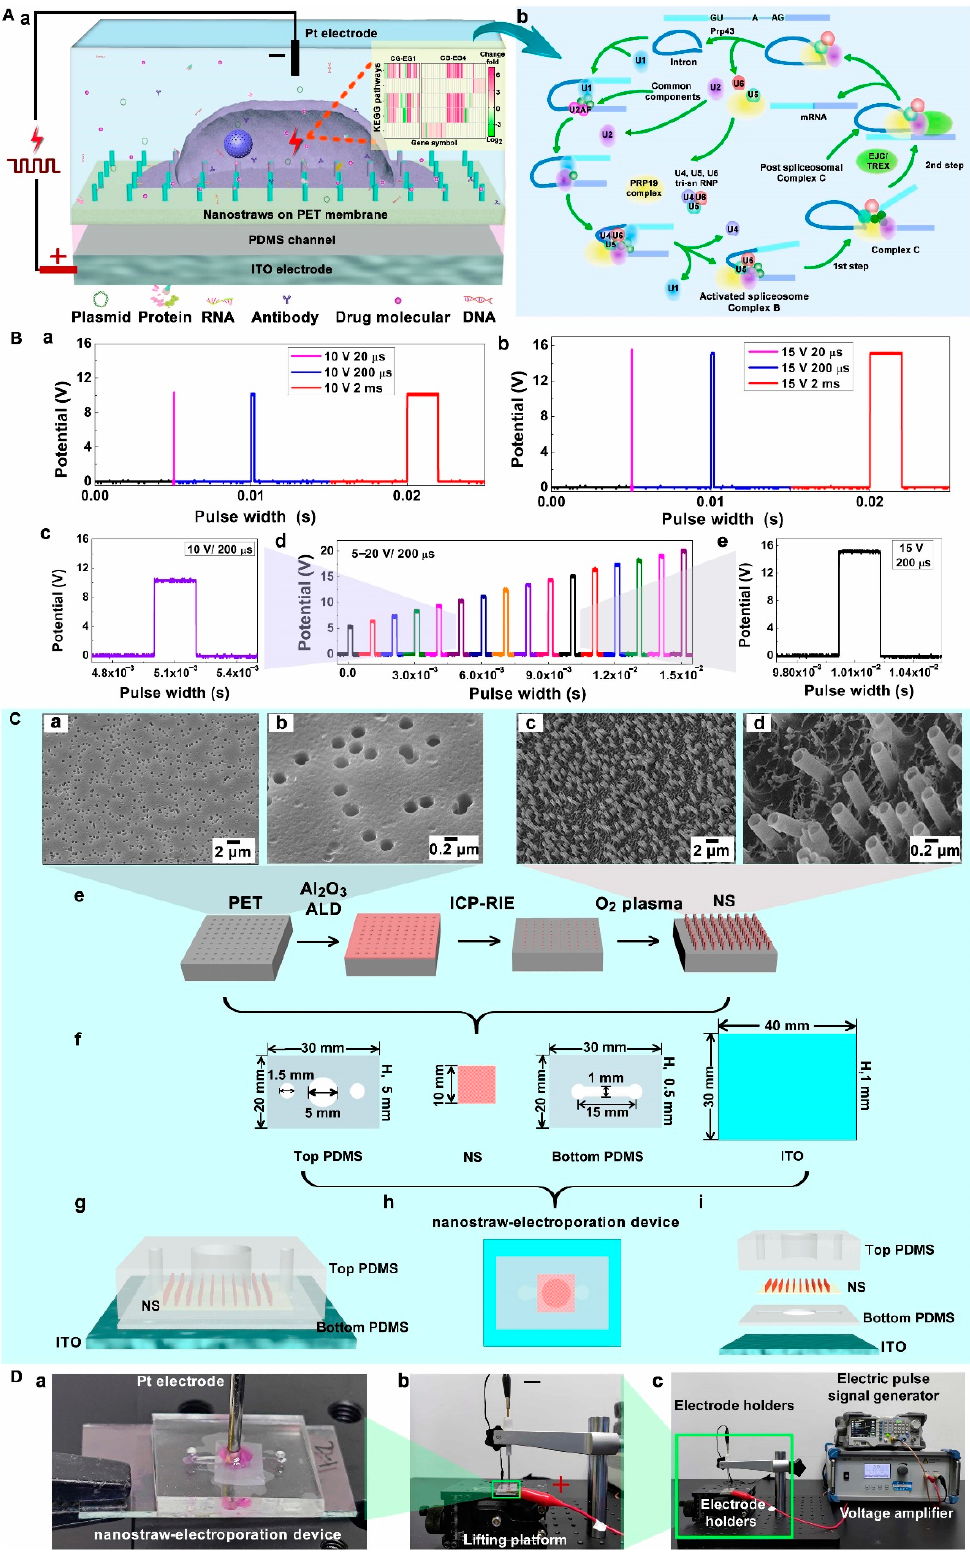
Figure 1. ( A ), Schematic illustration of the nanostraw-electroporation system. ( A-a ),